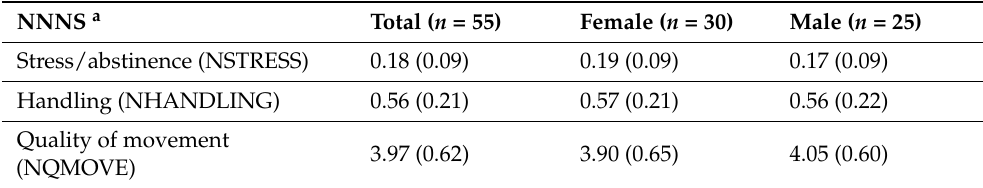
Table 2. Neurobehavioral outcomes of the included infants, Mean (SD).